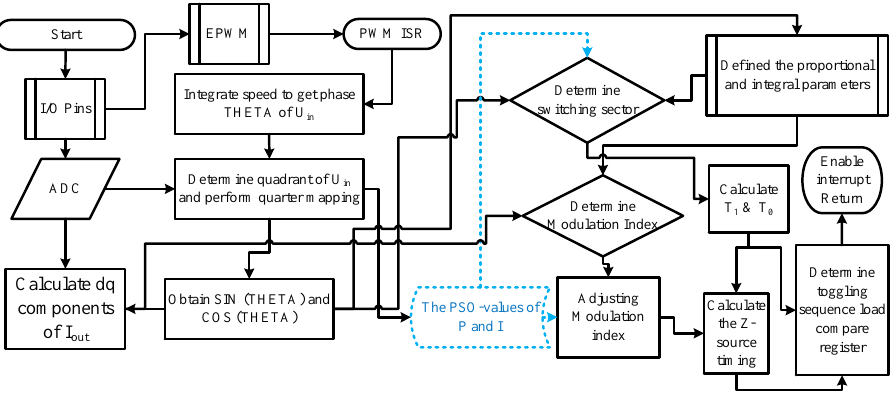
Figure 17. The flowchart to program digital signal processor (DSP).